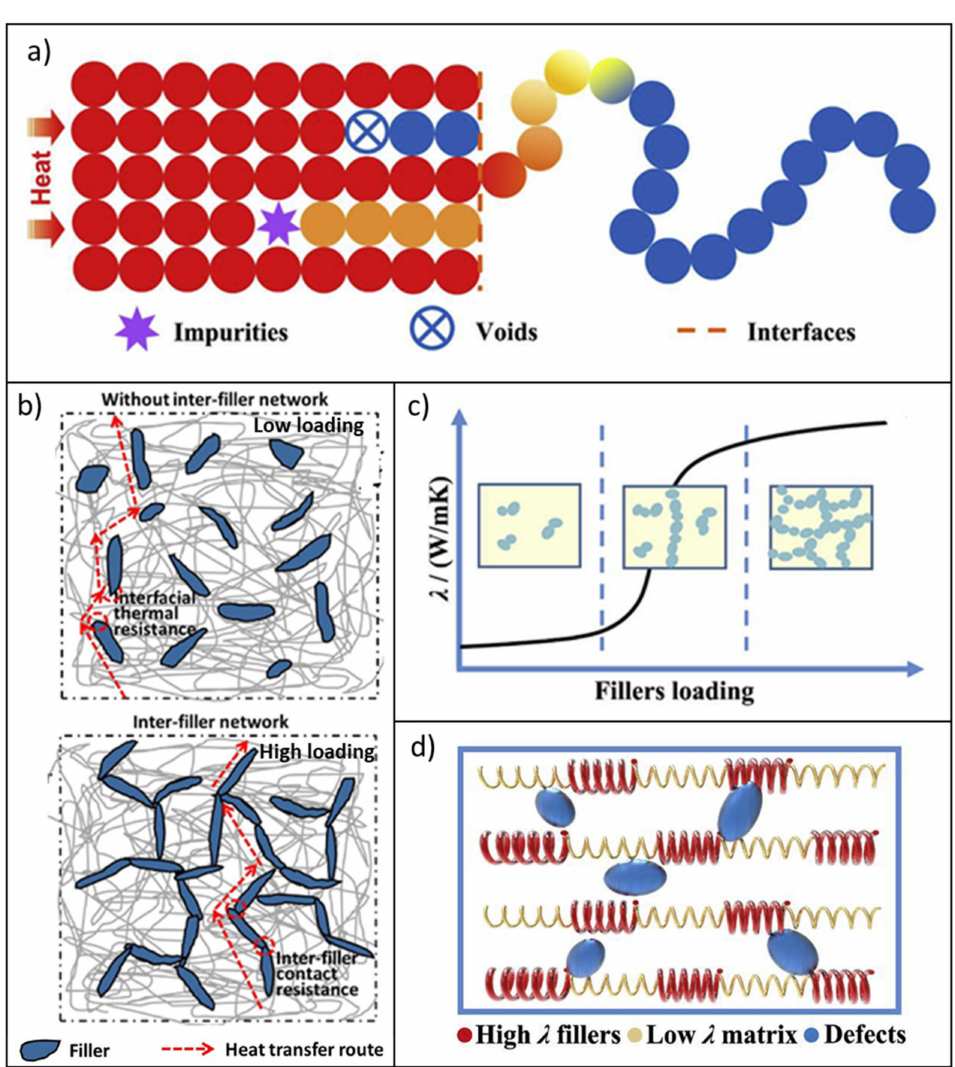
Figure 1. ( a ) Mechanism of heat transport in polymer composites; ( b ) generation of thermally conductive pathways in polymer composites as a function of filler loading; schematic diagrams of ( c ) percolation and ( d ) thermoelastic coefficient theories that describe the thermal conductivity in polymer composites. Adapted from [14] (© 2021 Elsevier Ltd. All rights reserved.) and [16] (© 2021 Elsevier B.V. All rights